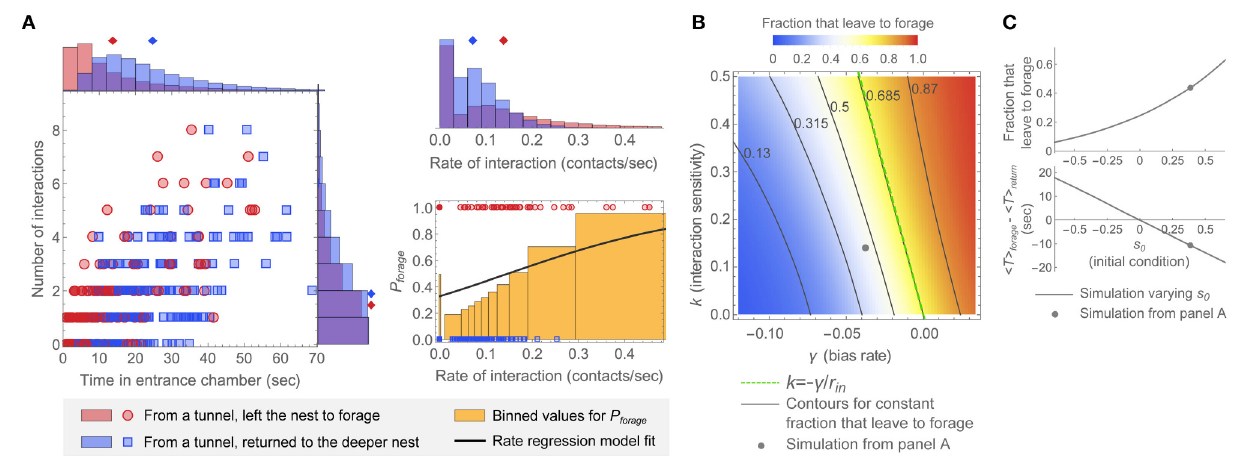
FIGURE 6 | Representative simulated distributions and model parameter dependence. (A) Simulated distributions of N , T , and r , and rate regression model fit of P forage to the simulated data. Plots were generated in the same manner as for the data of Figures 3 , 4 . Parameters for this example were chosen so that the simulations resemble the observation of colony 2: k = 0.14, γ = − 0.038 , s 0 = 0.39, and σ = 0.21. The mean input interaction rate, r in = 0.083 , was calculated from the data for this observation (see Figure S2). The 2D plot and corresponding N , T, and r distributions display data for 400 simulated ants. The plot of P forage (bottom right) shows rates as points for 200 simulated ants. (B,C) Effects of changing parameters around the values used in this example. (B) Dependence of the fraction of simulated ants leaving the nest to forage on the interaction sensitivity k and bias rate γ . Parameter values for s 0 , σ , and r in were the same as in (A) . The point shows the result from (A) , the dashed line shows the “constant decision fraction” line for k = − γ/ r in , and the solid lines show evenly spaced contours at and around the line k = − γ/ r in . (C) Model dependence on the initial decision state s 0 . (top) Fraction that leave the nest to forage. (bottom) Difference in average decision time between groups of